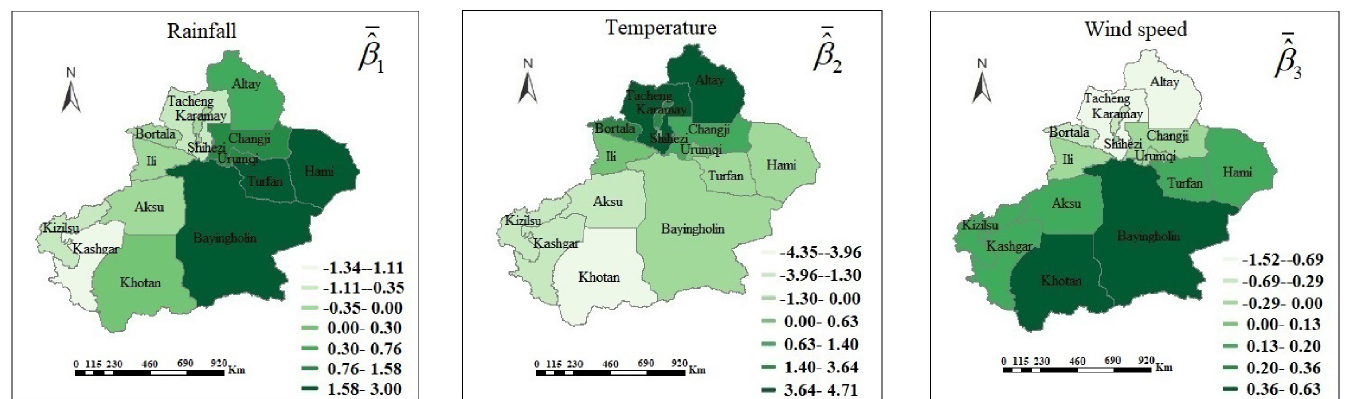
Fig 7. The mean coefficient estimations of three meteorological factors. It is generated by software ArcGIS 10.2 from http://eol.jsc.nasa.gov/SearchPhotos/.